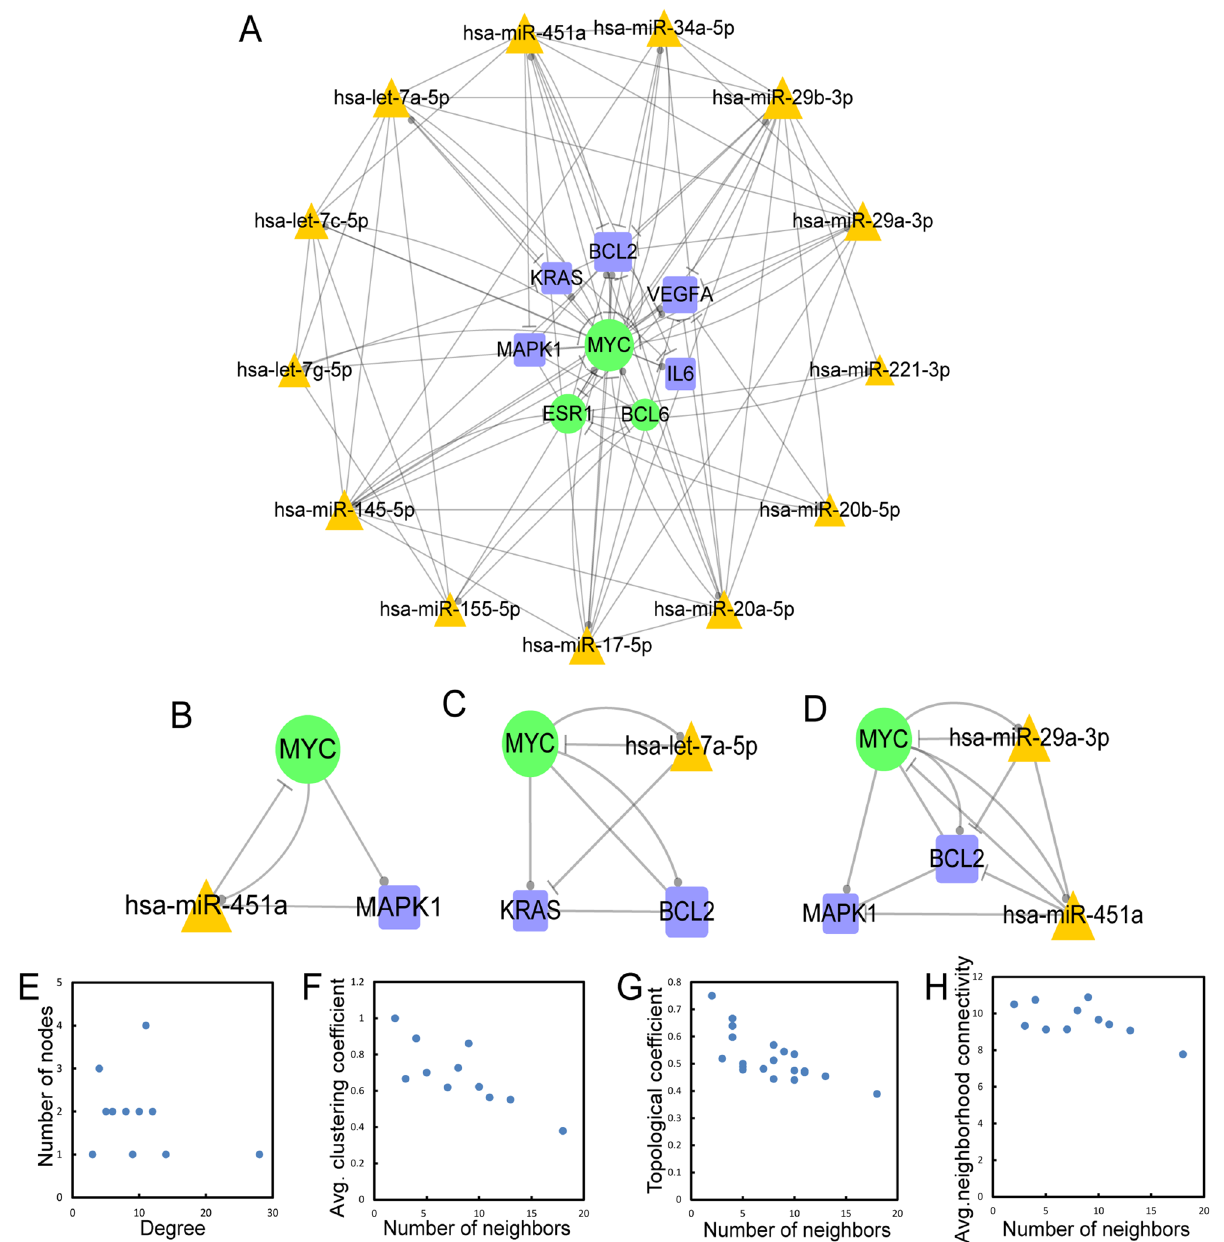
Figure 3. 3/4/5-node composite FFL motif-specific sub-network (CFMSN). ( A ) A global view of 3/4/5- node composite FFL motif-specific sub-network (CFMSN). Orange triangle represents miRNA, green round represents TF and blue square represents gene. A line ending in a circle represents the regulatory relationship, while, a line ending in a “T” represents the repression relationship. ( B – D ) The examples of 3/4/5 node composite FFL. ( E – H ) The basic features of the network include degrees, clustering coefficients, topological coefficients and neighborhood connectivity of the network. TF: transcription factor; FFL: feed-forward